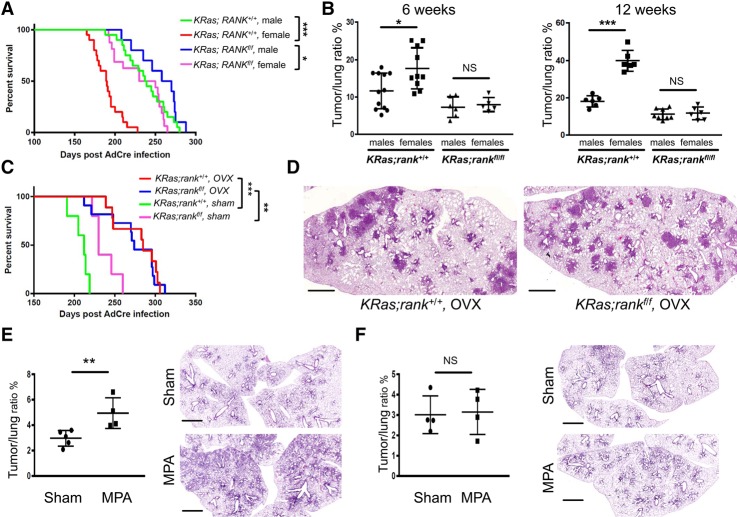
Female sex hormones can drive lung cancer via RANK. (A) Kaplan Meier survival curves for KRas;rank+/+ male (n = 20; median survival 238 d), KRas;rank+/+ female (n = 20; median survival 183 d), KRas;rankfl/fl male (n = 10; median survival 262 d), and KRas;rankfl/fl female (n = 16; median survival 215 d) mice injected intranasally with AdCre. (*)P < 0.05; (***) P < 0.001, log rank test. (B) Quantitative assessment of tumor to lung ratios among male and female KRas;rank+/+ and KRas;rankfl/fl mice at 6 and 12 wk after AdCre inhalation. Data from individual mice are shown ±SEM. (*) P < 0.05; (***) P < 0.001, χ2 test. (C) Kaplan Meier survival curves for KRas;rank+/+ ovariectomized (OVX) (n = 9; median survival 285 d), KRas;rank+/+ sham-treated (n = 5; median survival 210 d), KRas;rankfl/fl ovariectomized (n = 11; median survival 274 d), and KRas;rankfl/fl sham-treated (n = 5; median survival 235 d) mice injected with AdCre. (**) P < 0.01; (***) P < 0.001 (between the ovariectomized groups and their respective KRas;rank+/+ and KRas;rankfl/fl sham-treated littermate controls), log rank test. (D) Representative histological images of ovariectomized (OVX) KRas;rank+/+ and KRas;rankfl/fl females 30 wk after AdCre inhalation. Bars, 2 mm. (E,F) Quantitative assessment of tumor to lung ratios and representative histological images of medroxyprogesterone acetate (MPA)-implanted (MPA) as well as sham-treated (Sham) KRas;rank+/+ (E) and KRas;rankfl/fl (F) mice 8 wk after AdCre inhalation. MPA experiments were performed independently for the KRas;rank+/+ and KRas;rankfl/fl cohorts. Of note, for the MPA experiments, we used a lower dose of the AdCre virus to better uncover possible MPA effects and assessed lung tumorigenesis at an early time point as a surrogate for tumor initiation. (**) P < 0.01, χ2 test. Bars, 2 mm.